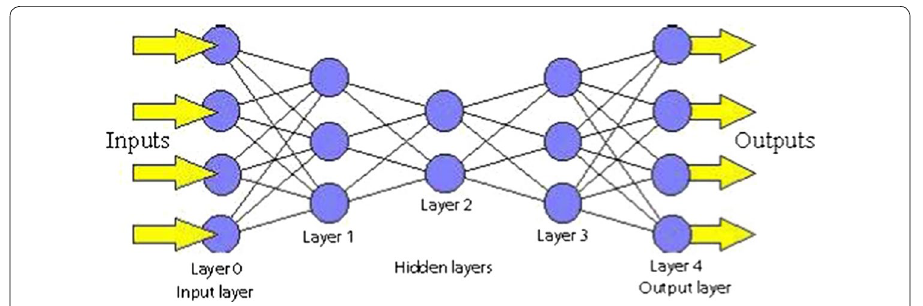
Fig. 1 Basic Neural Network Architecture for analysing medical